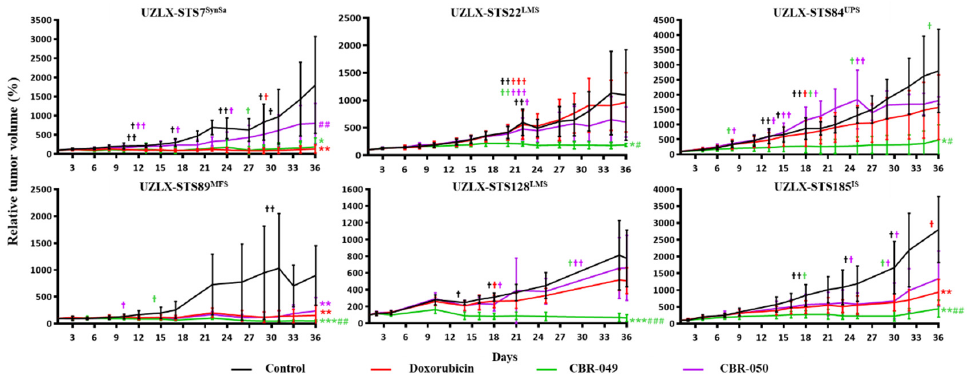
Figure 2. Relative tumor volume (%) compared to baseline in the patient-derived xenografts, presented as average ± standard deviation. Data from dropout animals were included in the graph but ex- cluded from the statistical analysis. Statistical significance was calculated using Mann–Whitney U